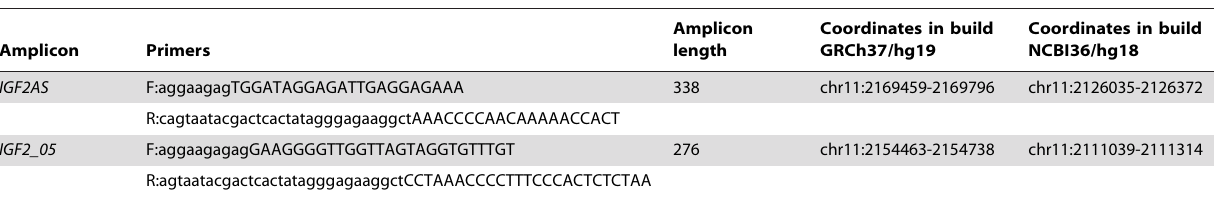
Table 1. IGF2AS and IGF2_05 amplicons.